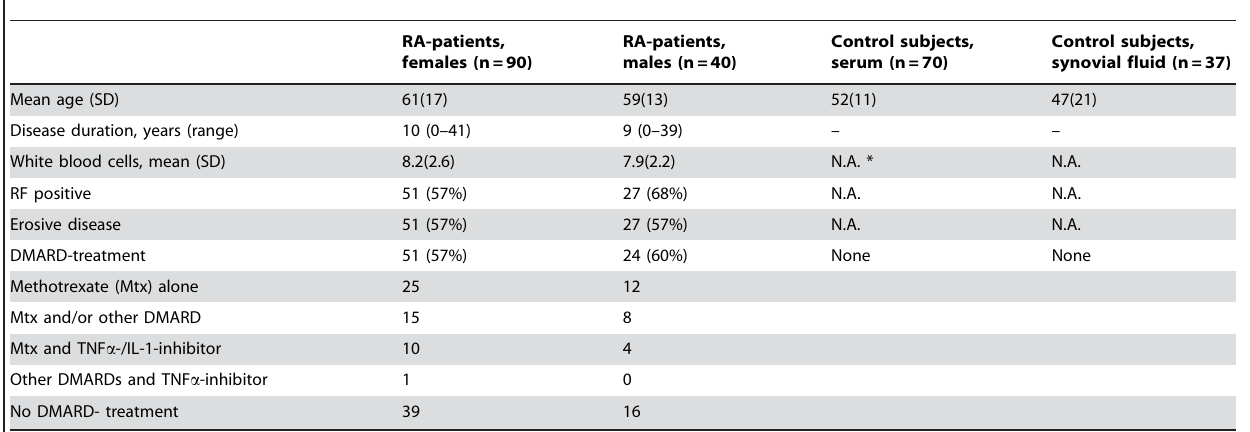
Table 1. Clinical data regarding 130 RA-patients and 103 controls participating in the study.